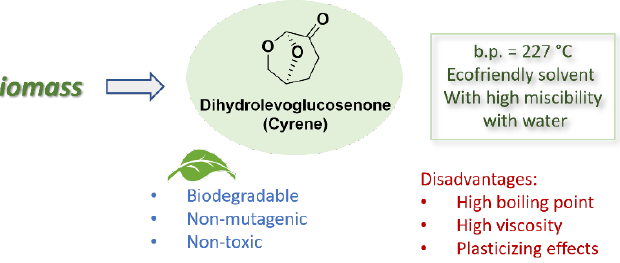
Figure 1. Structure of Cyrene and its most relevant “green” properties.